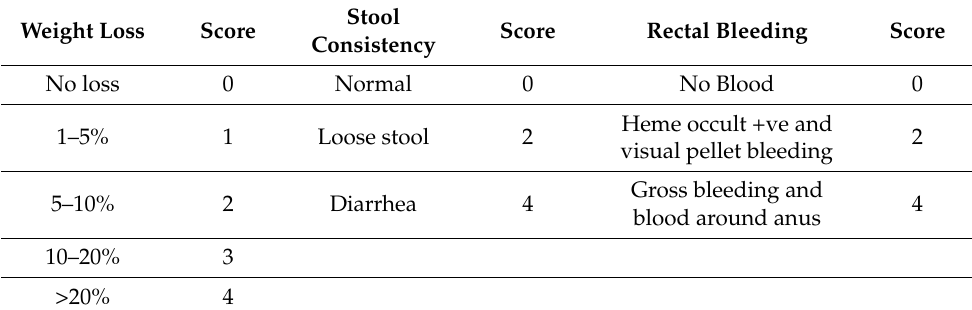
Table 1. Disease activity index score